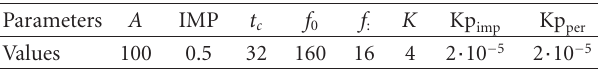
Table 1: Parameter reference values for the RQSM sensitivity